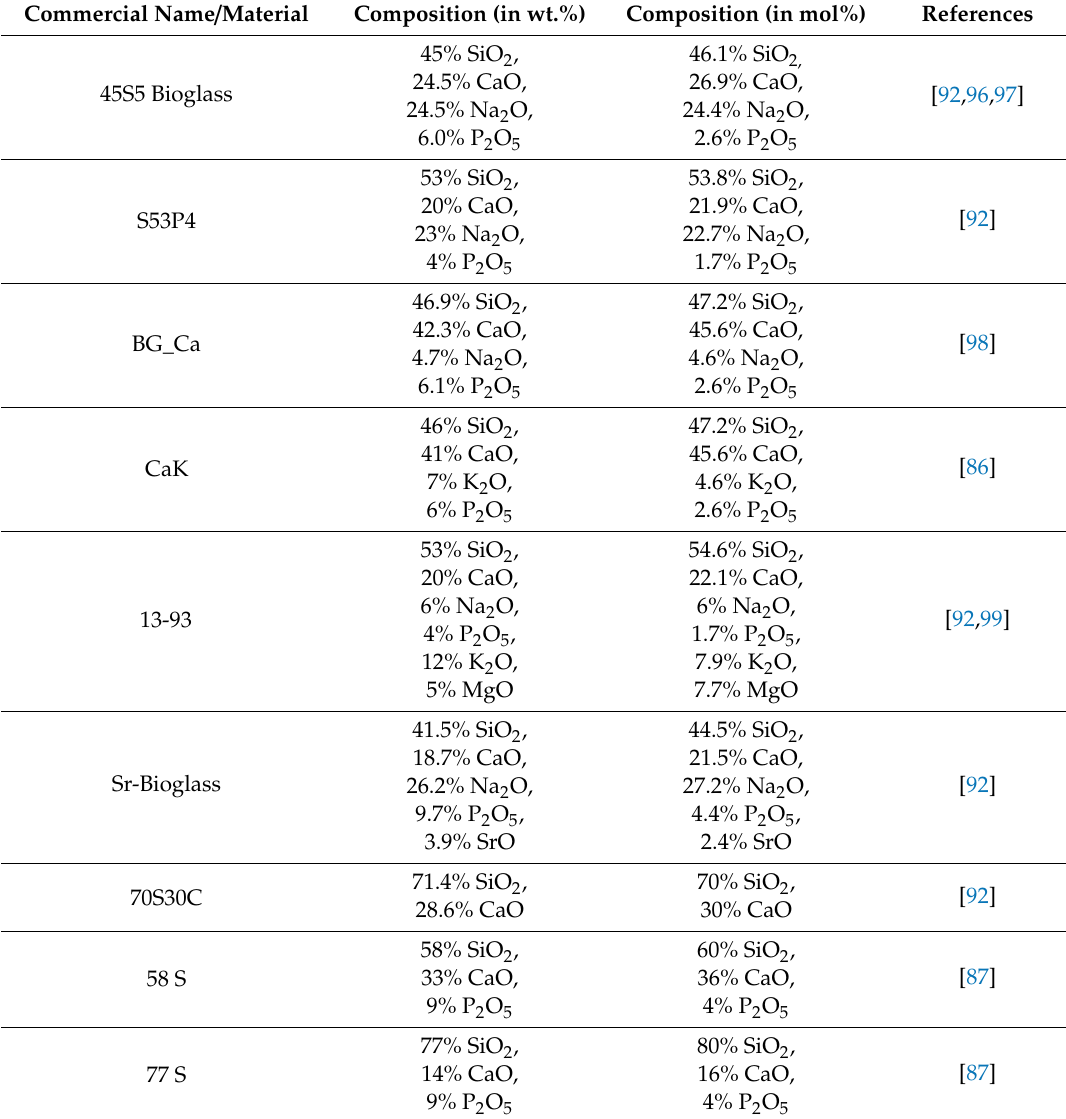
Table 2. Common bioactive glasses (for example, but not limited) used in medical devices and their